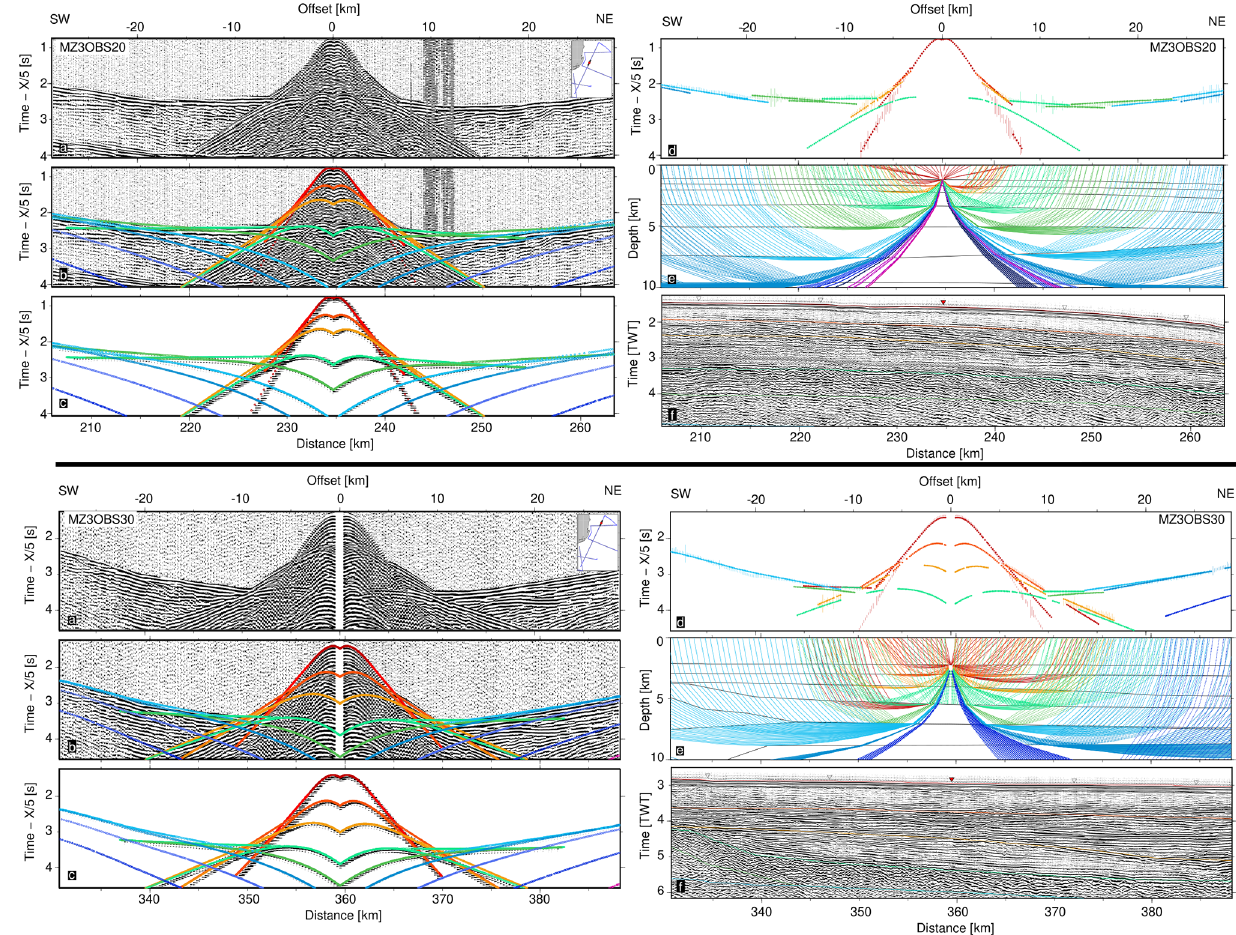
Figure 5. The same as Fig. 4. Sedimentary and volcano-sedimentary seismic phases in MZ3OBS20 (top) and MZ3OBS30